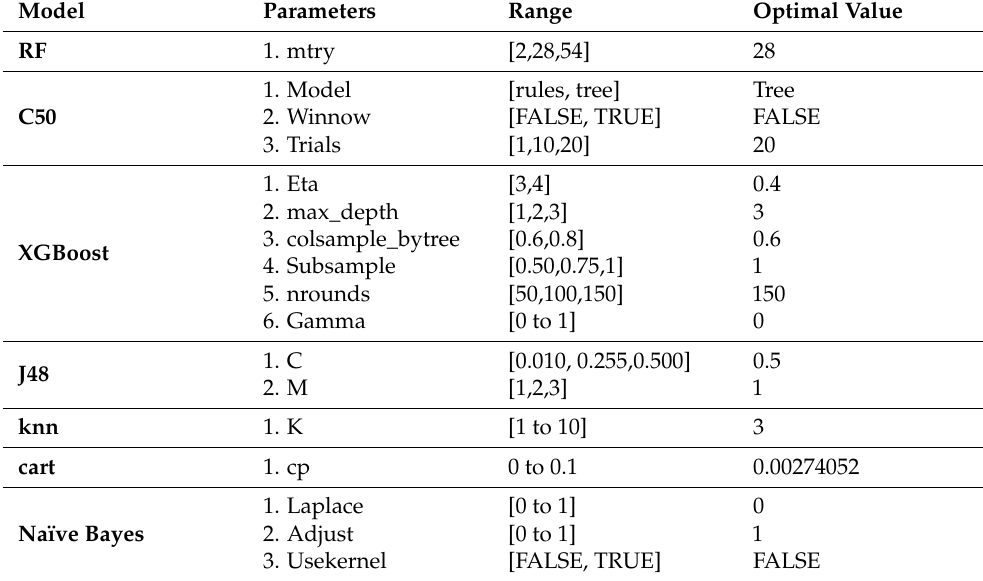
Table 3. The hyper-parameter tuning on the models used in this paper, where mtry is the number of randomly selected predictors, model is the model type, trials is the number of boosting iterations, eta is the learning rate, max_depth is the max tree depth, colsample_bytree is the subsample ratio of columns, nrounds is the number of boosting iterations, subsample is the subsample percentage, gamma is the minimum loss reduction, C is the confidence threshold, M is the minimum instances per leaf, K is the number of neighbors, cp is the complexity parameter, Laplace is the Laplace correction, adjust is the bandwidth adjustment, and usekernel is the distribution